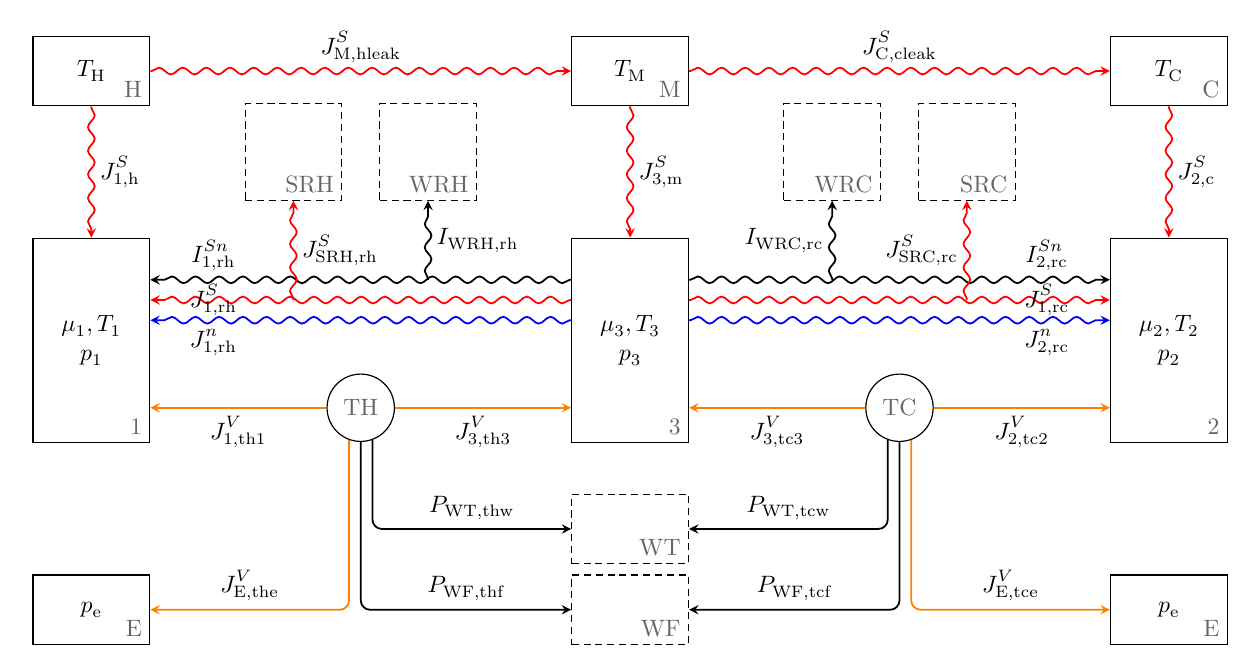
T T H , M , C ) and the